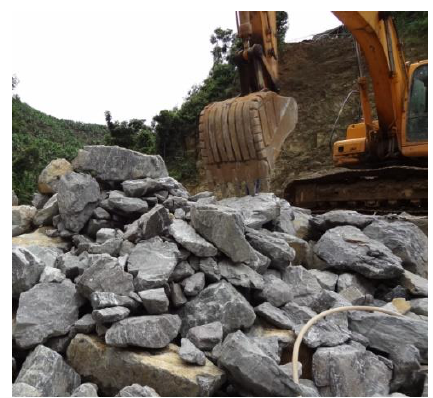
Figure 1. Rock block placement.